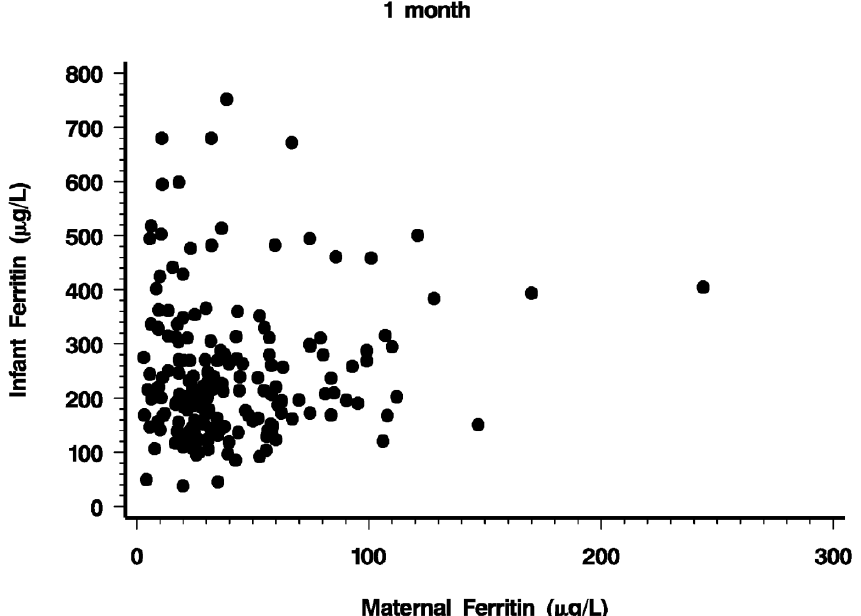
Figure 2. Relationship between maternal and infant plasma ferritin one month after birth ( r = 0.081, p = 0.283).